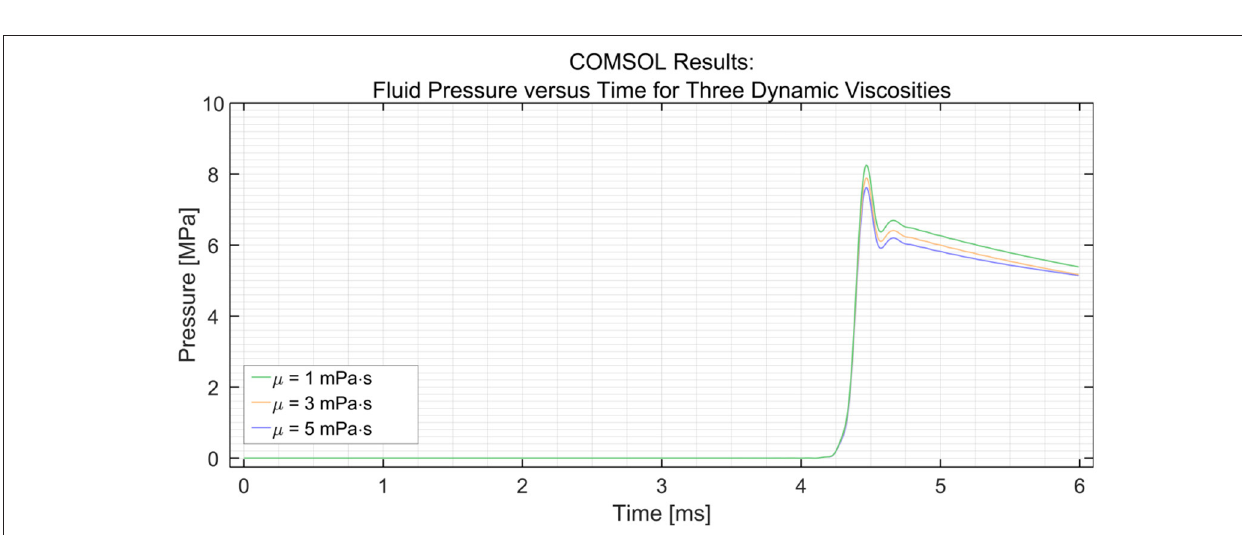
FIGURE 3 | Pressure variation at the input and the distal end vs. time in the PTFE shaft. The input pressure was set to 15 MPa.